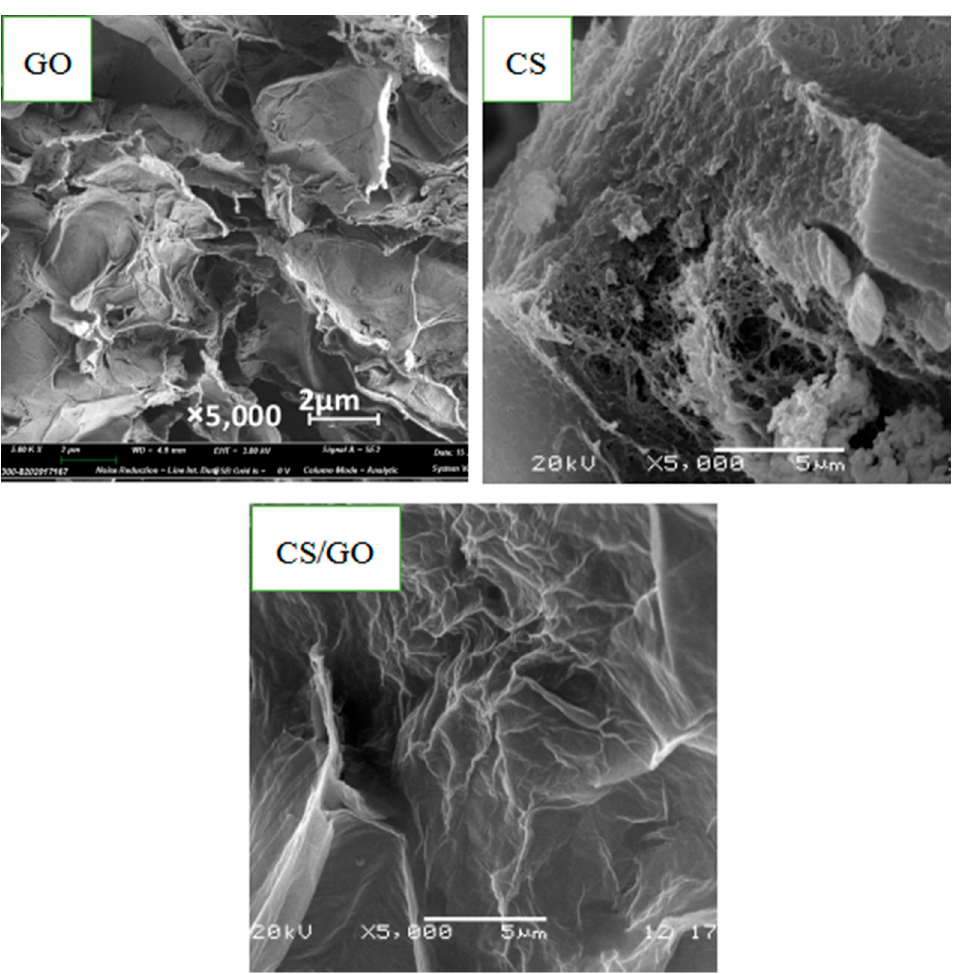
Figure 5. SEM photographs of GO aerogel, CS aerogel and CS/GO aerogel (5000×).